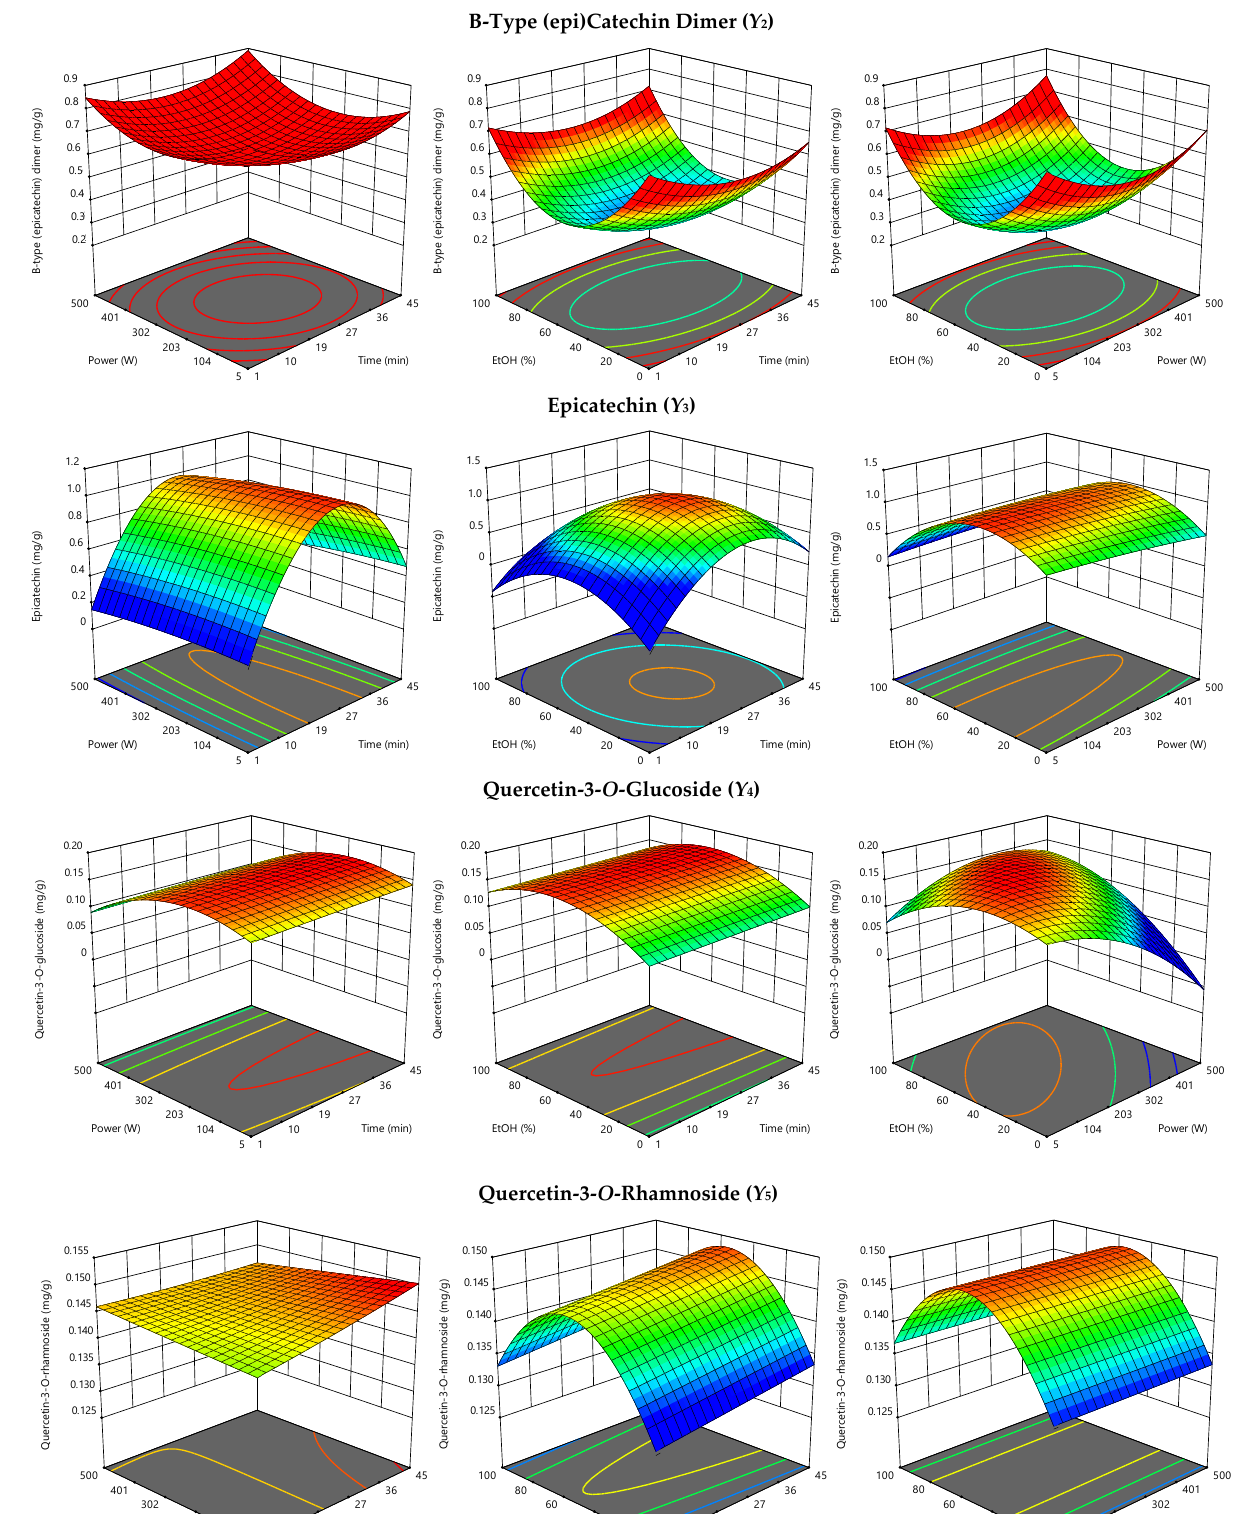
Figure 1. Response surface graphs for the combined effects of the independent variables on the content (mg/g) of individual flavonoids ( Y 2 – Y 5 ) recovered from kiwi peel. In each graph, the excluded variable was fixed at its optimal value.